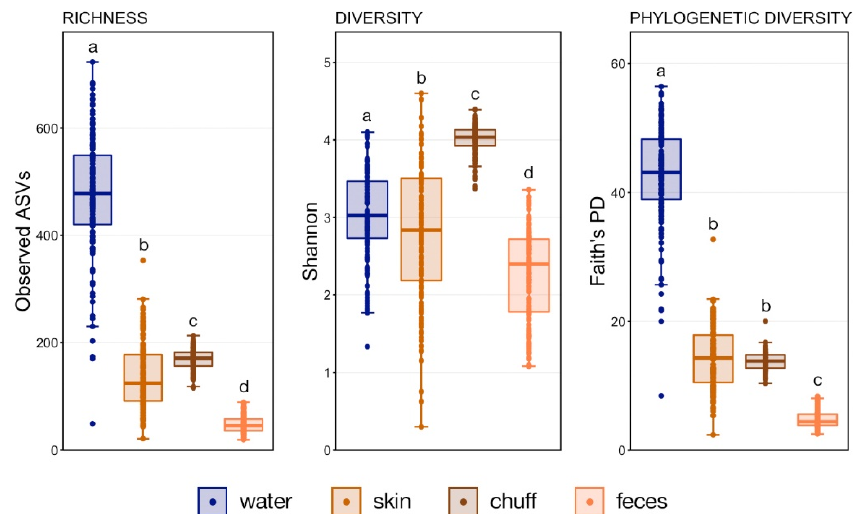
Figure 1. Boxplots demonstrating differences in richness (Observed ASVs), diversity (Shannon), and phylogenetic diversity (Faith’s PD) between water ( n = 149), skin ( n = 130), chuff ( n = 142), and fecal ( n = 144) samples. Significant differences are illustrated by different letters (pairwise Wilcoxon rank-sum with Benjamini–Hochberg correction, n = 130–149, p < 0.05).